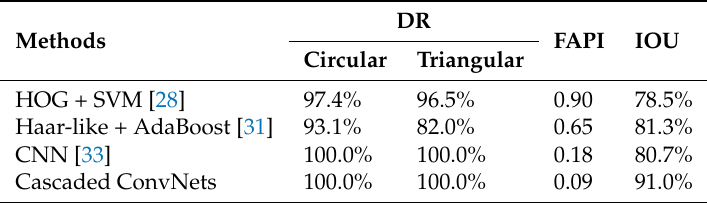
Table 3. Performance of different detection methods after the stage of supplemental